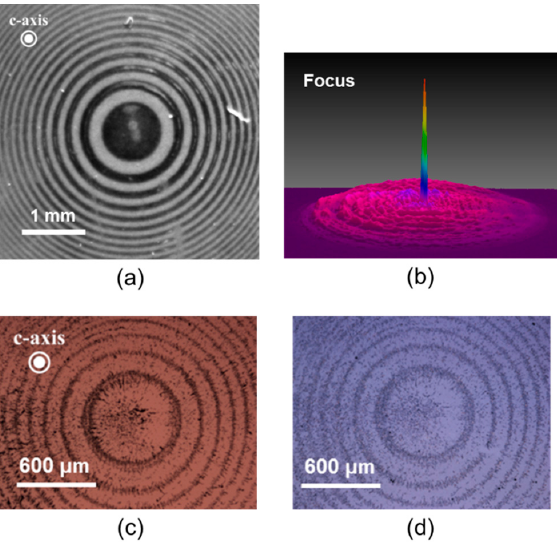
Figure 6. ( a ) Photography of a Fresnel lens fabricated with Al nanoparticles ( d ~70 nm), and ( b ) intensity profile of the diffracted light along a transversal direction at the focus acting as zone plate. ( c ) Microscopic image of a Fresnel pattern of Al nanoparticles on the LiNbO 3 :Fe and ( d ) this pattern transferred to a glass substrate. Reprinted with permission from Martínez ‑ Muñoz et al. Opt. Lett. 2016 , 41 , 432. Copyright 2016 Optical Society of American (reference [38]).